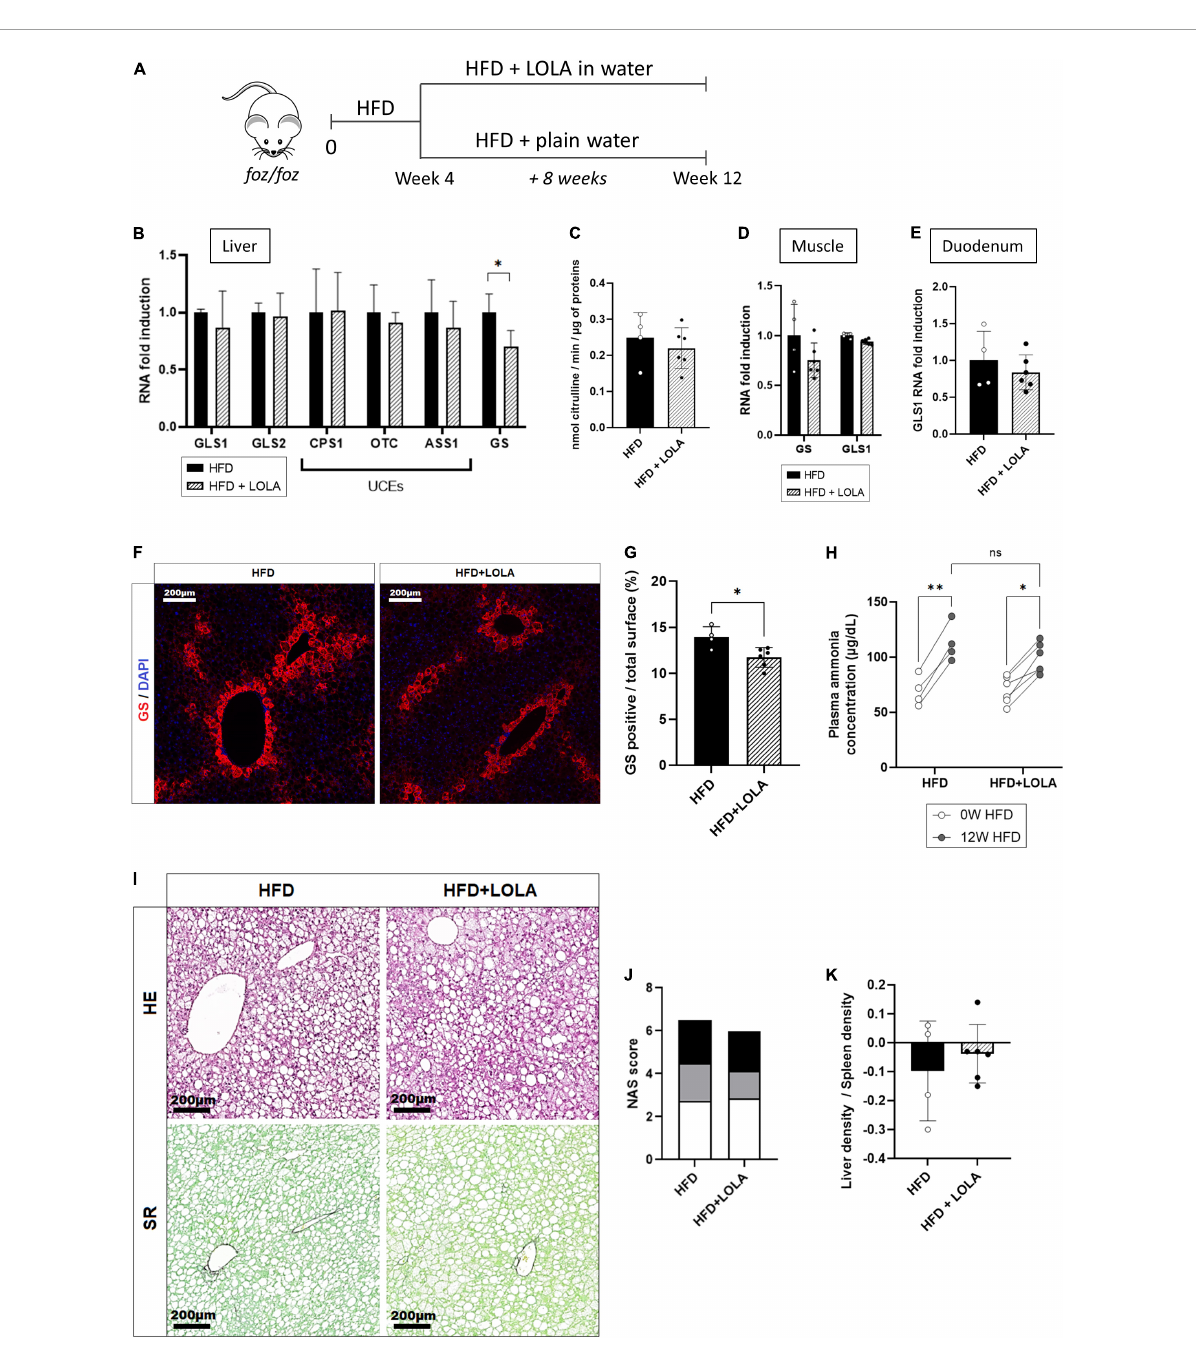
FIGURE3 L-Ornithine L-Aspartate (LOLA) does not improve hepatic ammonia detoxification. (A) LOLA was administered in drinking water to HFD-fed FOZ mice (HFD + LOLA) for the last 8 weeks of the 12 weeks dietary experiment. Treated mice were compared with FOZ HFD given plain water (HFD). (B) mRNA levels of glutaminase (GLS) 1 and 2, of urea cycle enzymes (UCEs): carbamoyl phosphate synthetase (CPS1), ornithine transcarbamylase (OTC), Argininosuccinate synthetase (ASS1), argininosuccinate lyase (ASL), arginase (ARG1), and of glutamine synthetase (GS) in liver tissue from HFD and HFD + LOLA ( n = 4–6); (C) Enzyme activity of OTC in liver tissue from HFD and HFD + LOLA ( n = 4–6); (D) mRNA levels of GLS1 and GS in muscle tissue (gastrocnemius) from HFD and HFD + LOLA ( n = 4–6); (E) mRNA levels of GLS1 in duodenum from HFD and HFD + LOLA ( n = 4–6); (F) GS protein expression levels assessed by immunofluorescence in liver tissue from HFD and HFD + LOLA and (G) quantification of GS-positive tissue (in percentage) in liver sections ( n = 4–6). (H) Plasma ammonia concentrations measured in systemic blood from HFD and HFD + LOLA ( n = 4–6); (I) Representative hematoxylin-eosin (H&E) and Sirius red (SR) staining of liver sections from HFD and HFD + LOLA; (J) Non-alcoholic fatty liver disease activity score (NAS) ( n = 4–6); (K) Liver-to-spleen density measured in vivo by micro-CT in HFD and HFD + LOLA after 12 weeks of diet ( n = 4–6). All data are presented as mean ± SD, ∗ p < 0.05, ∗∗ p < 0.01. Statistical tests used: (C,E,G,J,K) Unpaired two-tailed t -test. (H) Repeated-measures two-way ANOVA and (B,D) two-way ANOVA followed by post hoc Bonferroni